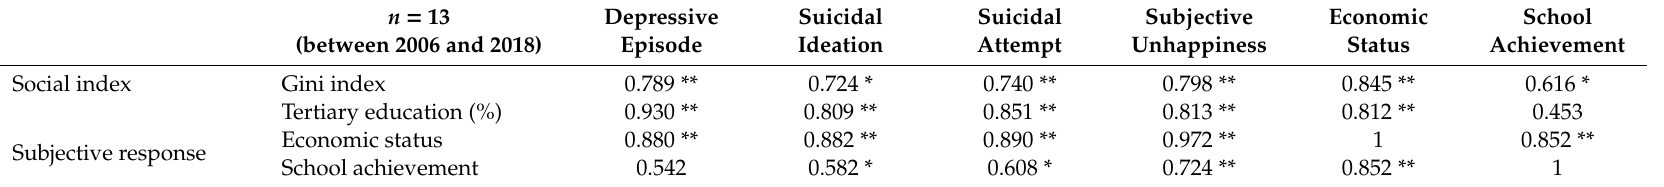
Table 4. Correlation of the changes between social index and survey responses between 2006 and